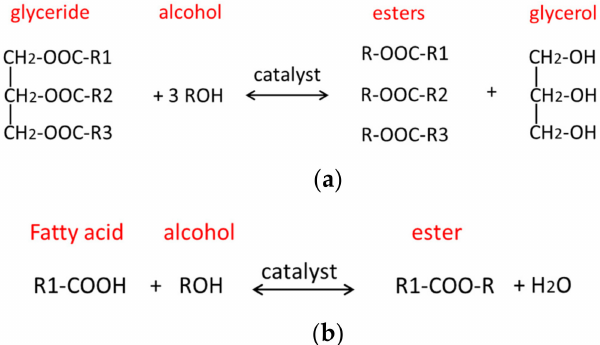
Figure 14. Reaction equations for biodiesel production: ( a ) transesterification of glyceride with alcohol; ( b ) esterification of fatty acid and